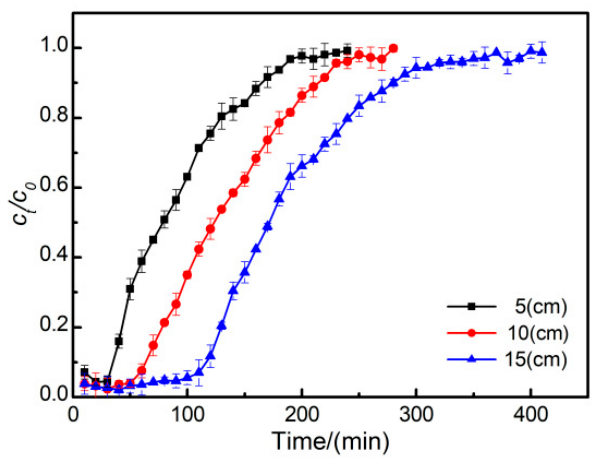
Figure 7. Effects of bed height on breakthrough